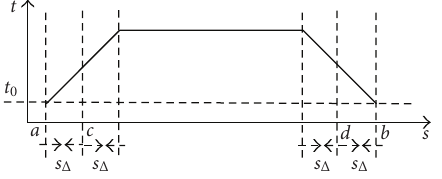
Figure 10: Computation time for the filtering and backprojecting at source point y ( s ). The time of the filtering is same at all source points and denoted by t 0 .